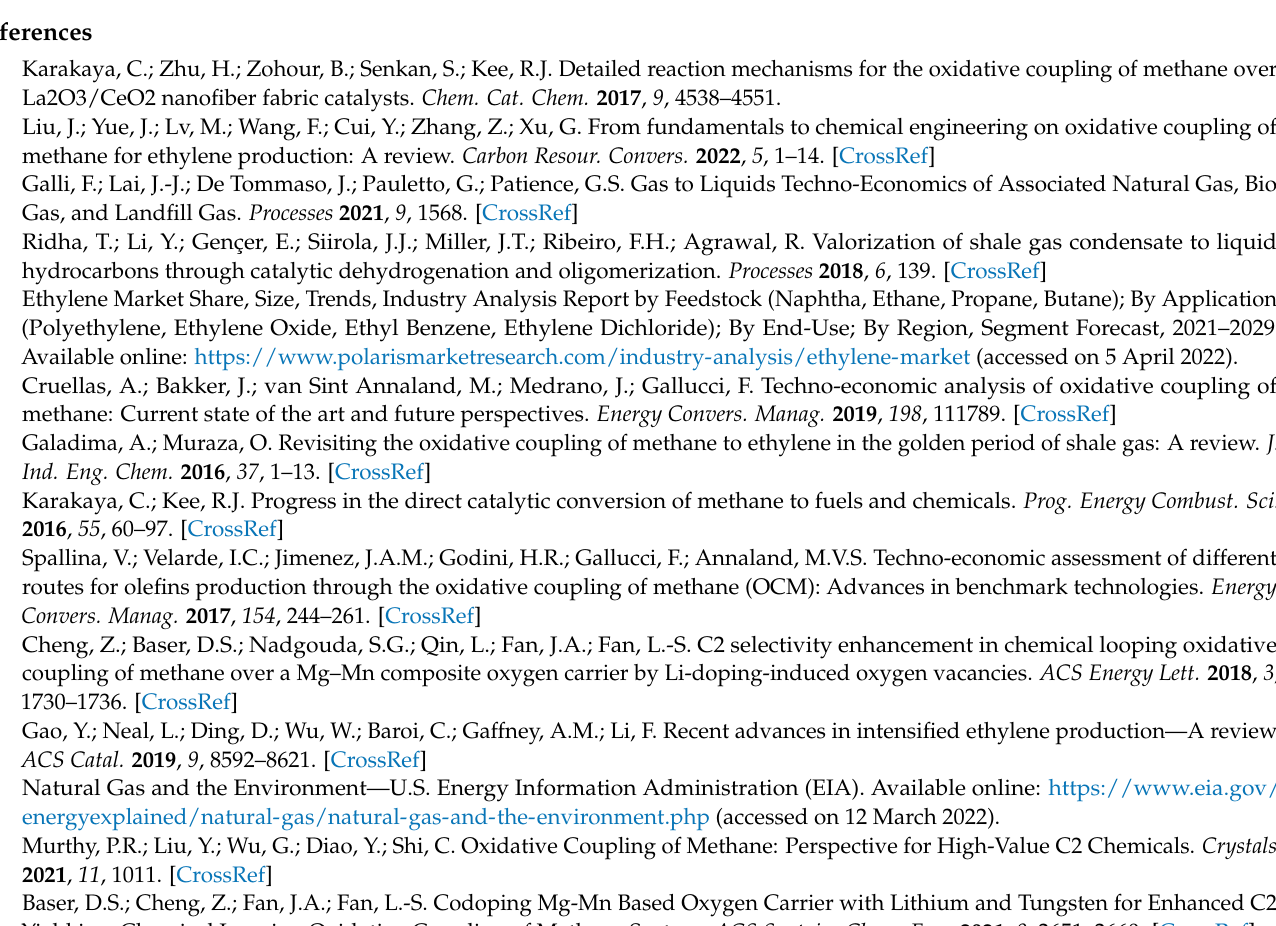
tion; Figure S2: Reaction scheme; Figure S3: Ethylene purification section breakdown; Figure S4: Temperature–interval diagram of the process; Figure S5: Heat balance around a temperature interval; Figure S6: Process simulation of the OCM plant; Figure S7: Molar composition profile for the inlet and outlet streams of the reactor; Table S1: Key streams results obtained from the